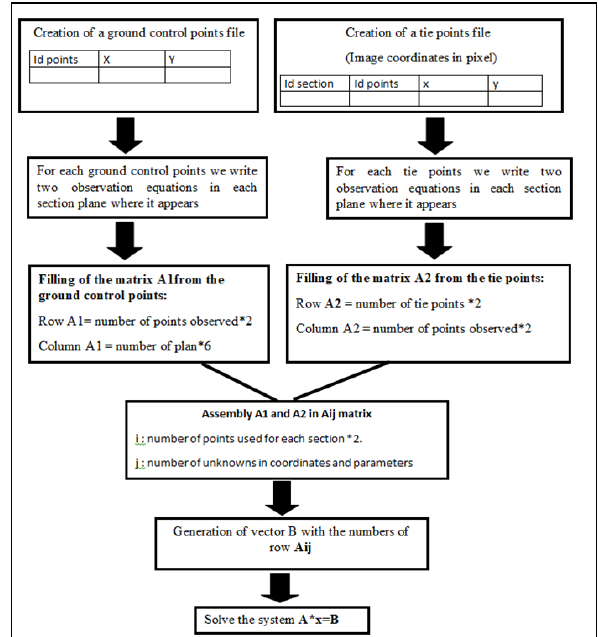
Figure 3. Framework of the proposed